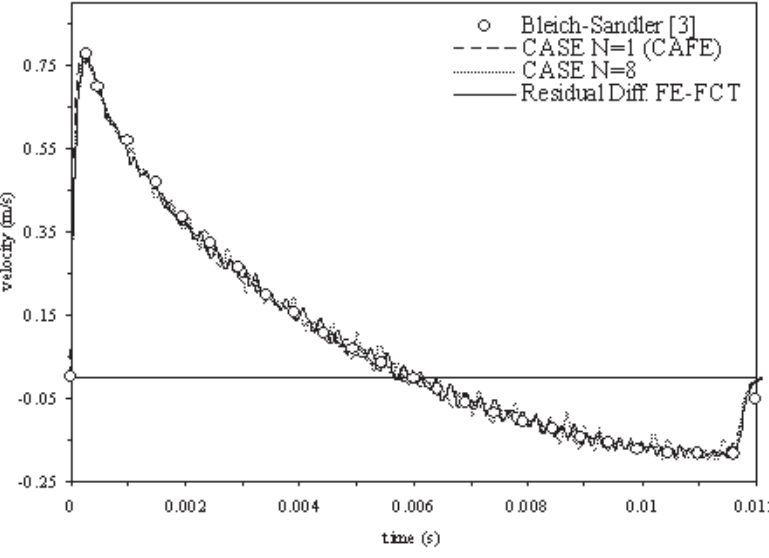
Fig. 17. Bleich-Sandler problem results for the velocity of m 1 using CAFE ( β = 0.25), 8th order CASE ( β = 0.25), and residual diffusion FE-FCT ( η D = 0.125, η A = 0.10).